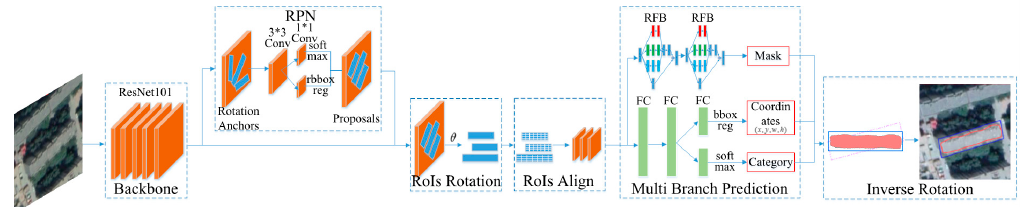
Figure 1. Schematic architecture of the proposed method.